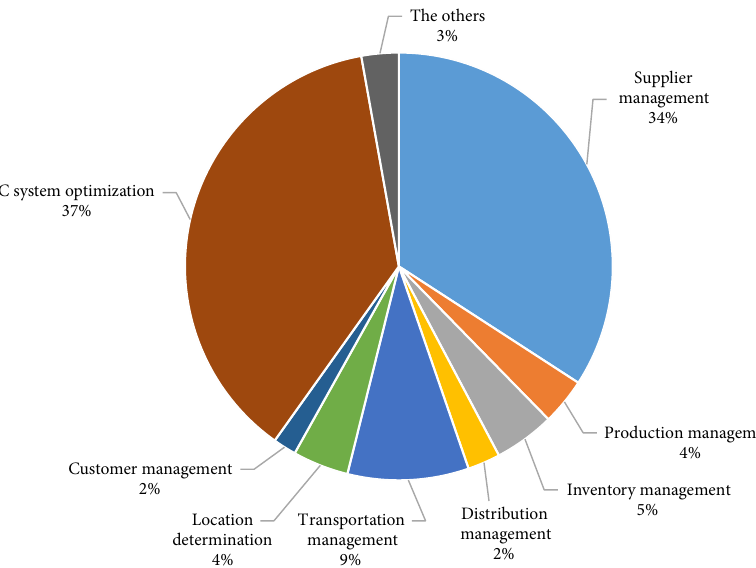
Figure 5. Distribution of the types of